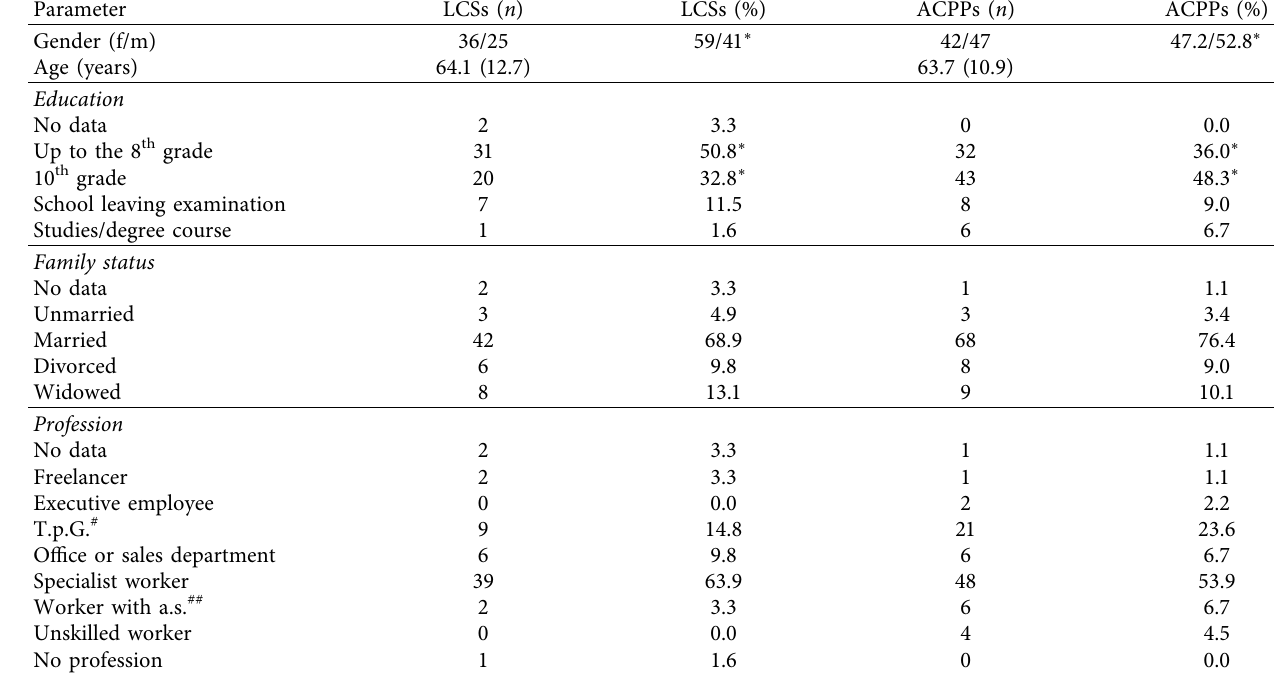
Table 1: Demographic and sociopsychological data of patients with cancer history ≥ 5y (LCSs) and acute cancer pain patients (ACPPs).